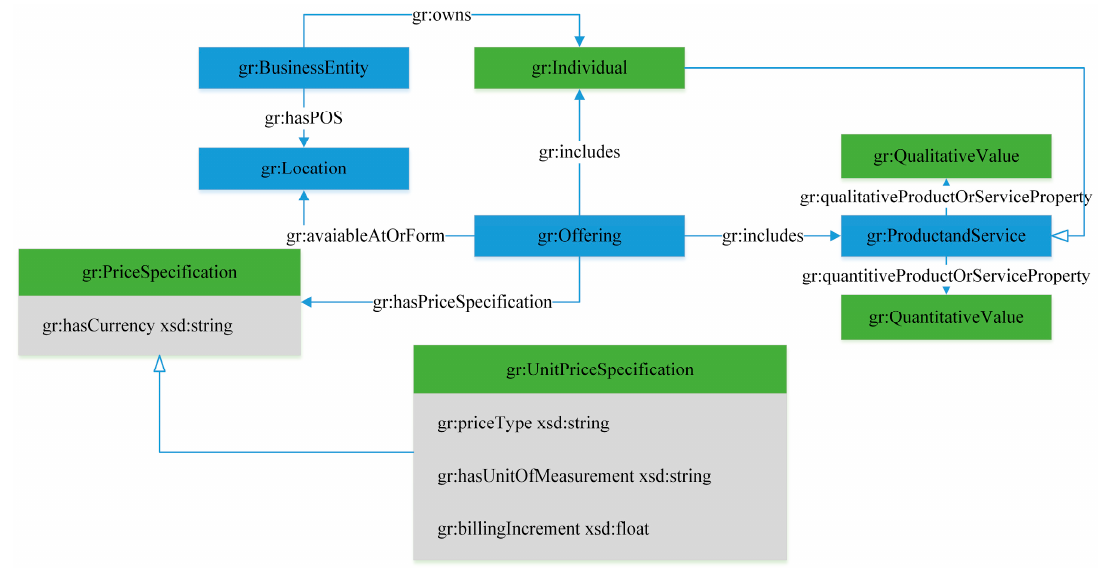
Figure 5. Part of the GR ontology.